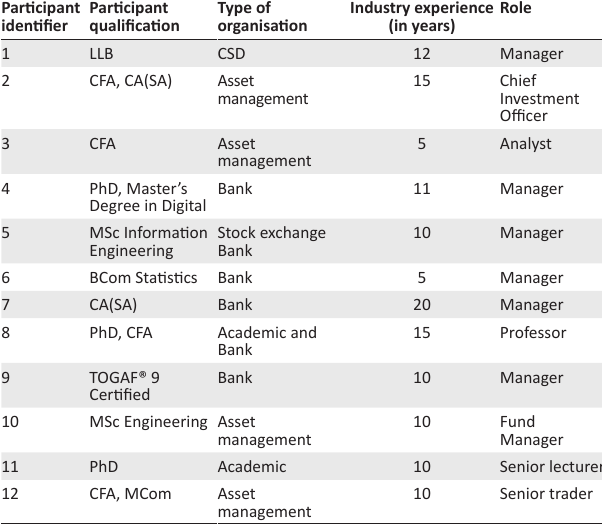
TABLE 2: Participants’ descriptors. Participant Participant identifier